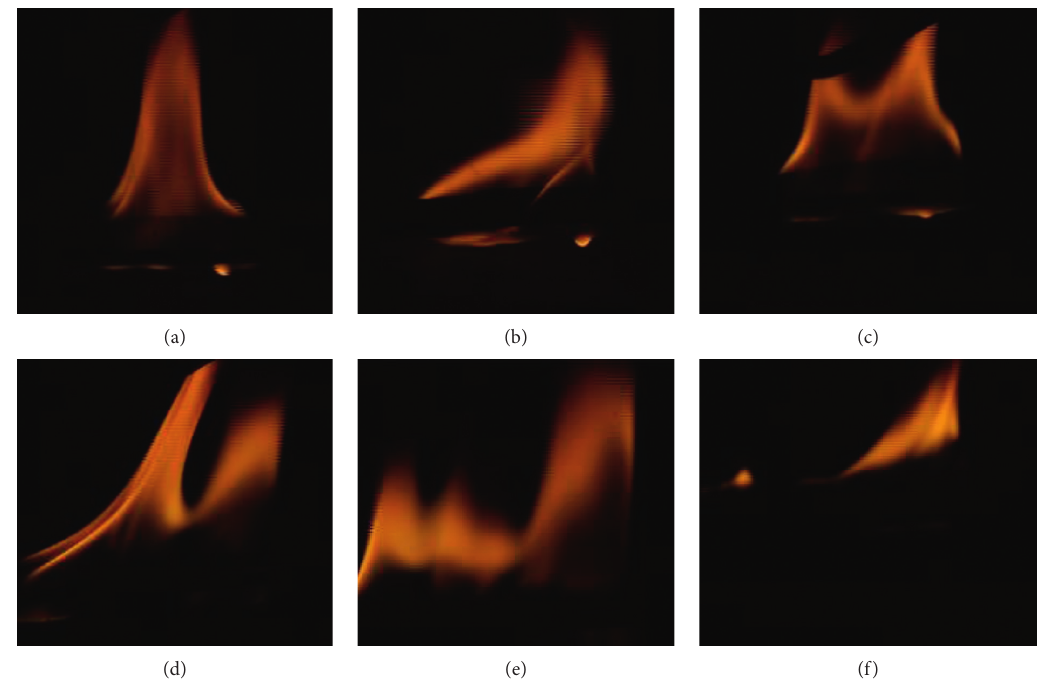
Figure 7: Images of flame spread under calm condition. (a) t � 4s, (b) t � 8s, (c) t � 18 s, (d) t � 43 s, (e) t � 67 s, and (f) t � 143 s.